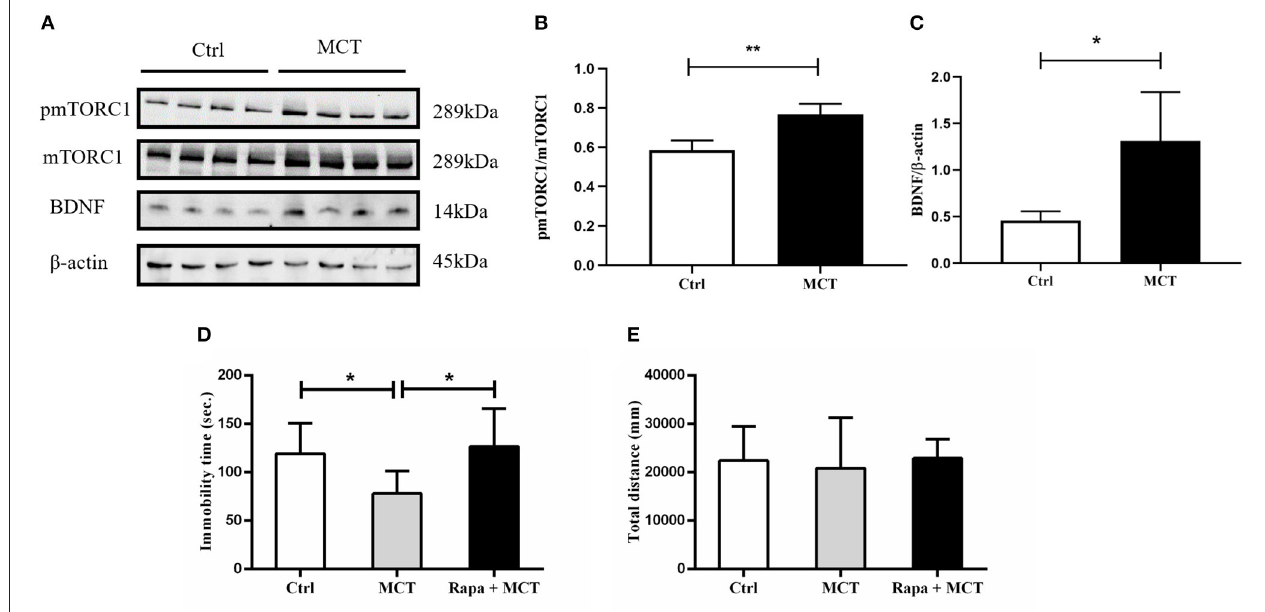
FIGURE 5 | Western blot results from the mPFC and the effect of rapamycin on animal behavior. (A) Western blot images of the control group and MCT group; (B) MCT significantly increases the ratio of p-mTORC1/mTORC1; (C) MCT significantly increases the expression of BDNF; (D) compared to the control group, MCT significantly reduces the immobility time in the FST; (E) total distance in the OFT is not significantly different from controls, the MCT group and rapamycin + MCT group. n = 4/group; Crtl: control; Scop: scopolamine; Rapa: rapamycin; *: p < 0.05; ** p < 0.01.